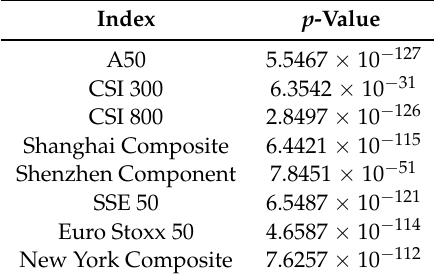
Table 5. Wilcoxon test comparing the error rate in the first and last iterations ( p -values).